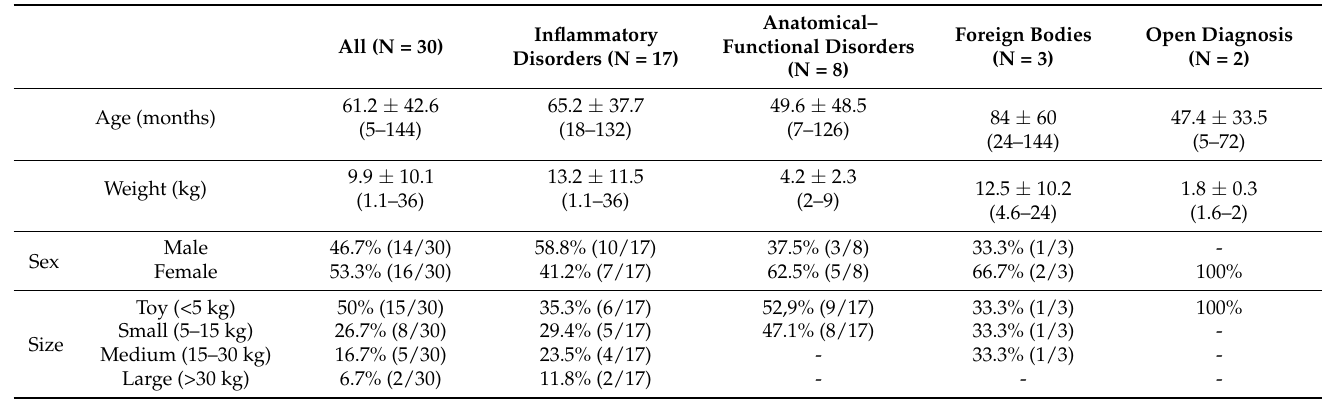
Table 1. Signalment by the main diagnosis subgroups.